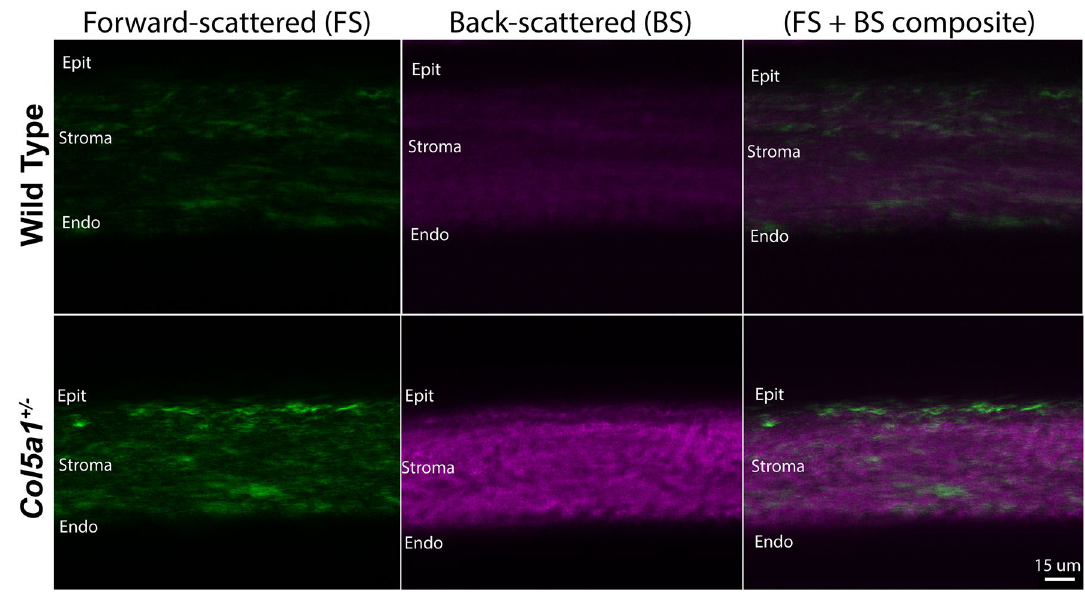
Figure 4. Cross-section SHG images of corneas obtained immediately after enucleation and without tissue fixation or manipulation. Weaker forward-scattered and backward-scattered signal is noted in the wt corneas. Representative images of Col5a1 +/− (n = 6) and wt (n = 6) corneas.